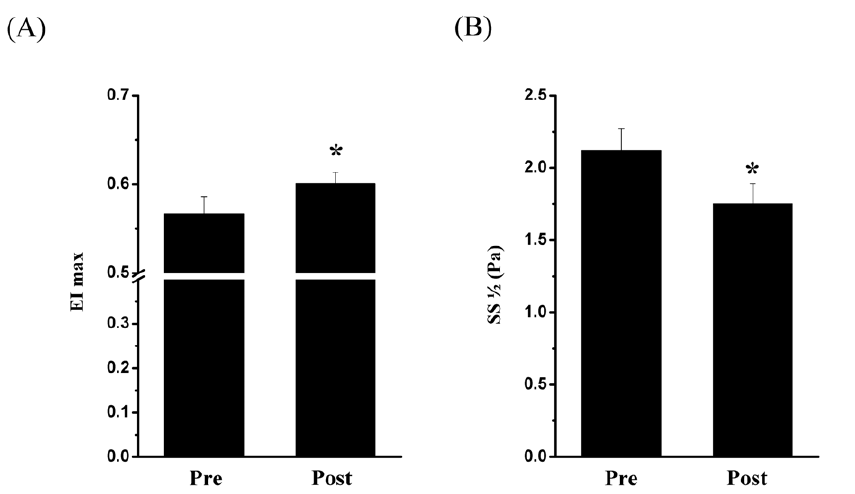
Figure 7. Influence of AMRT on RBC deformability. RBC deformability was obtained before (Pre) and after (Post) AMRT. (A) EImax significantly increased from Pre to Post exercise ( P , 0.05). (C) SS K significantly decreased Post AMRT. Data are presented as mean 6 S.E.M of n=15.